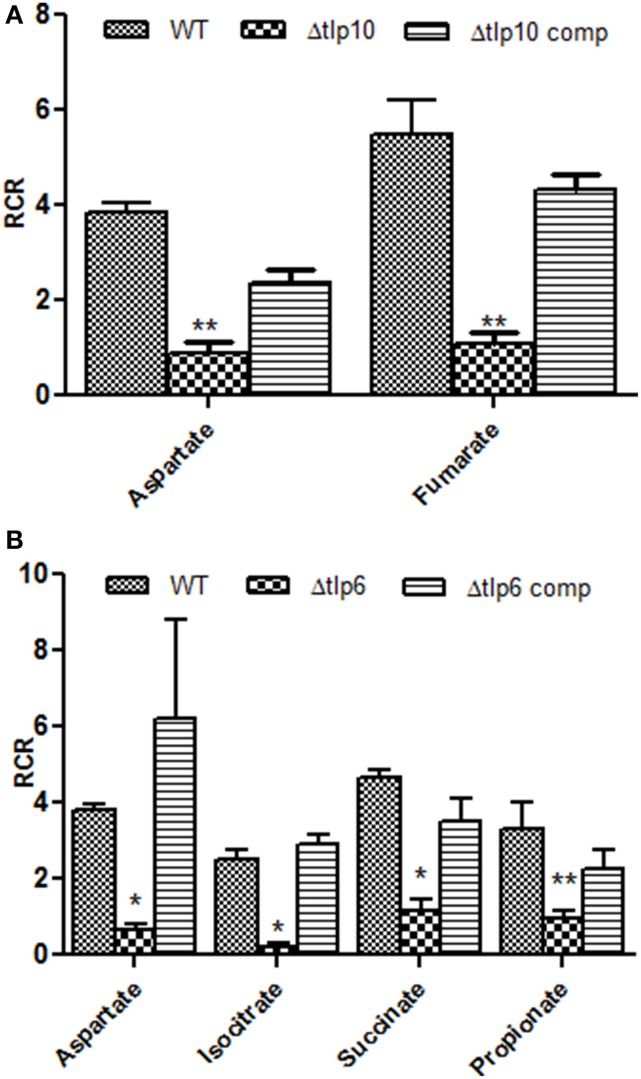
The Δtlp mutants that are defective in chemotaxis toward essential nutrients. Chemotaxis of tlp10
(A) and tlp6
(B) was assessed by determining the relative chemotactic ratio (RCR) which is the ratio of bacterial numbers migrating toward the chemical in the syringe to the bacterial numbers migrating toward the chemotaxis buffer. Chemotaxis was determined using the capillary method and significant results were further confirmed using the disc diffusion method (Table S3). Mucin and a ΔcheY mutant were used as a positive and negative control, respectively. An RCR-value of 2 or above indicates chemotaxis toward the test chemical. Only those Δtlp mutants with a significant defect in chemotaxis are shown and the complete chemotaxis results for all compounds tested are listed in Table 2. The data represent the average and SE of three experiments with 3 replicates in each experiment. *P ≤ 0.05, **P ≤ 0.01.